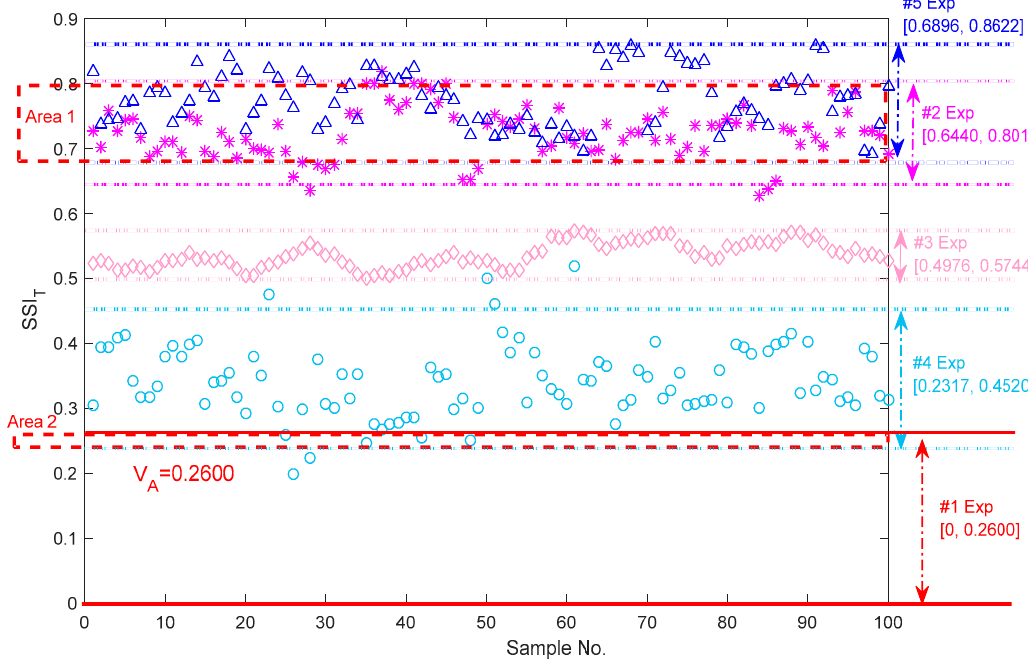
Figure 10. Upper and lower boundaries of the SSI T for distinguishing bearing vibration signals generated from different faults.